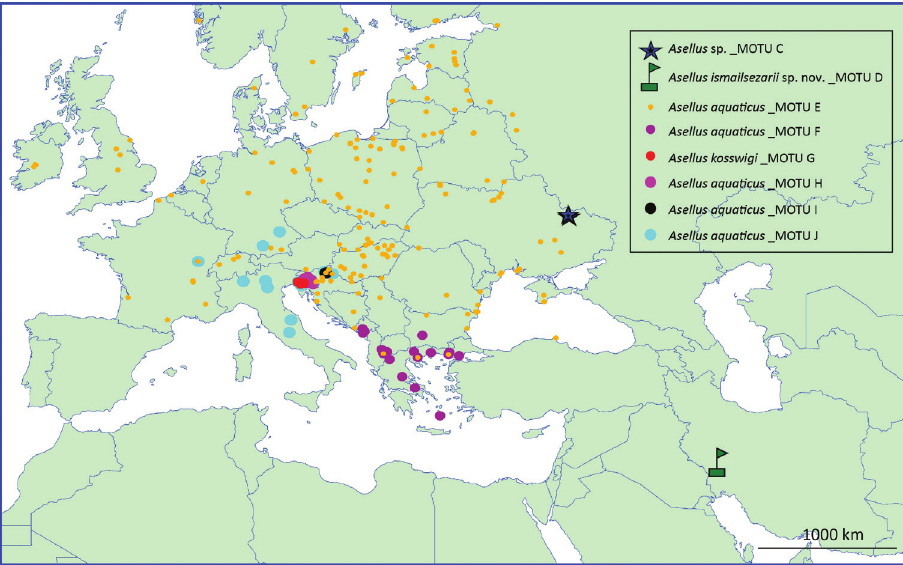
Figure 9. Map showing the distribution of molecular operational taxonomic units (MOTU) within the “ Asellus pattern”. Site locations for Asellus hilgendorfii (Japan) and Mesoasellus dybowskii and Limnoasellus poberezhnii (Lake Baikal, Russia) are not shown. Colors and symbols as in Fig.